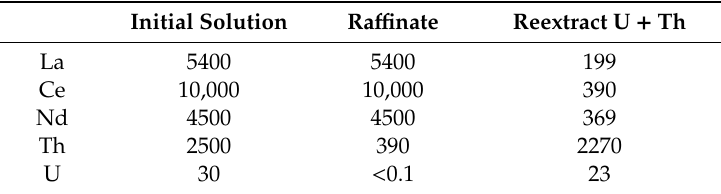
Table 6. The content of REEs, uranium and thorium at various stages of the technological scheme (in mg / L) in the second approach. Initial Solution Ra ffi nate Reextract U + Th La 5400 5400